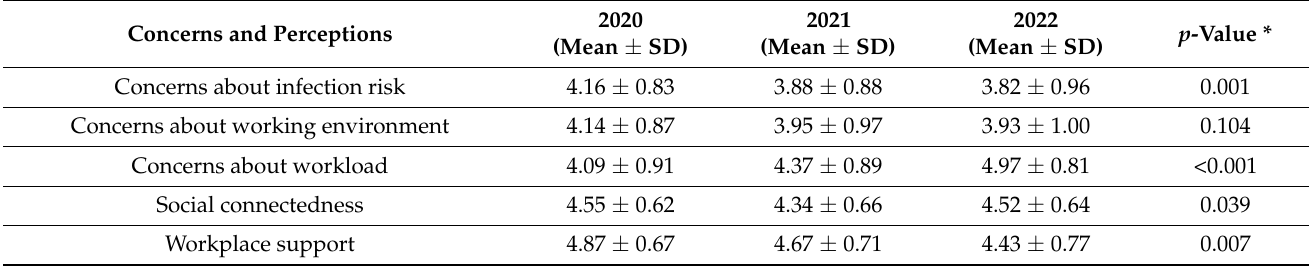
Table A4. The mean scores for the different categories of ED HCWs’ concerns and perceptions amongst the 160 matched HCWs.